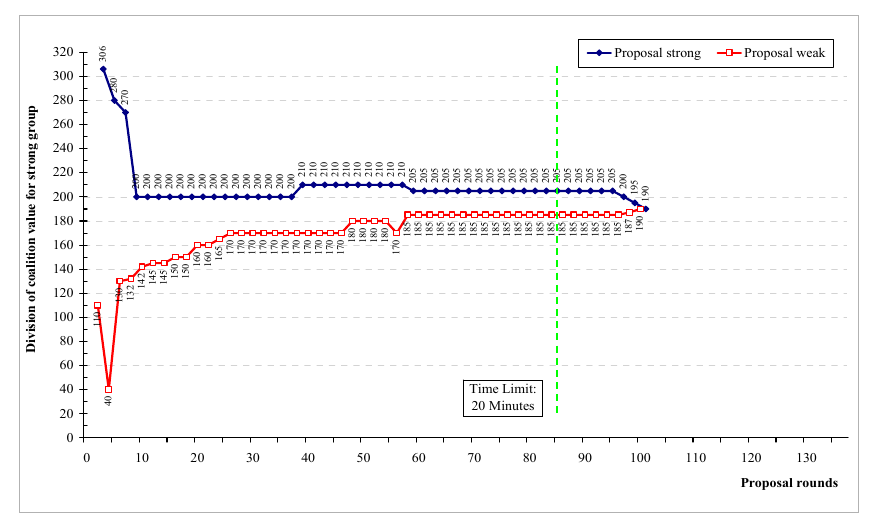
Figure A2. Session 6 in CHI.